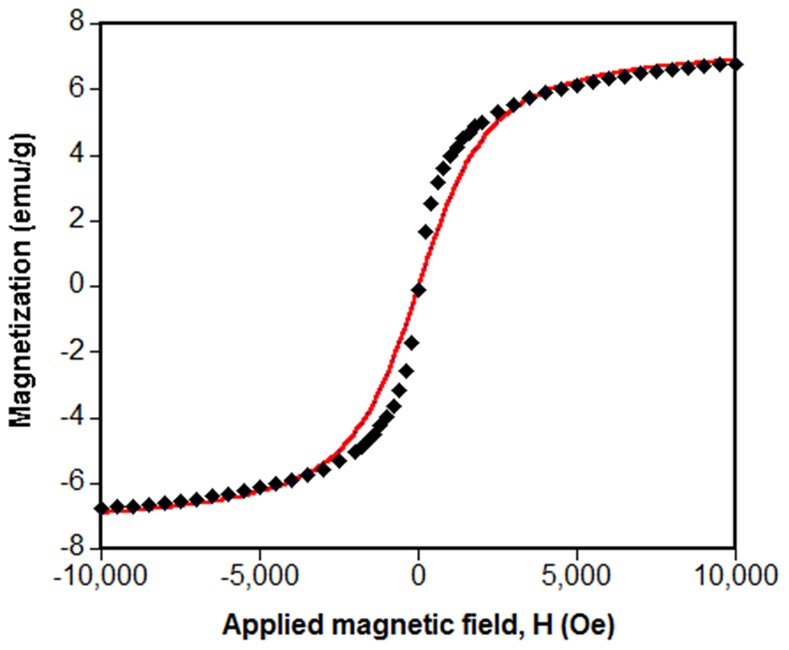
Magnetization curve of the magnetite-waste tea composite at room temperature.The points were obtained from VSM measurement, while the solid line was the best fit from the Langevin function assuming the composite particles were monodisperse.